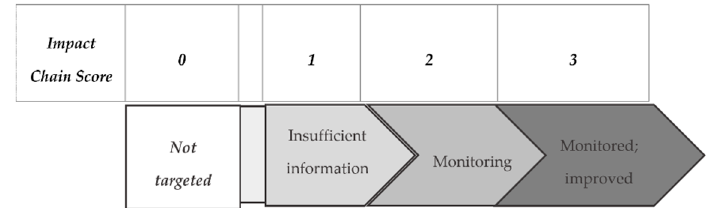
Figure 1. Impact Stages Chain. The 25 project implementation reports were given a score of 0–3 against each of the Sustainable Development Goals to reflect their contribution to the Goals. 0 = not targeted; 1 = insufficient information is given in the project implementation report; 2 = variable is being monitored or has been identified (no improvement yet); 3 = variable is being monitored and improvement is clearly demonstrable.